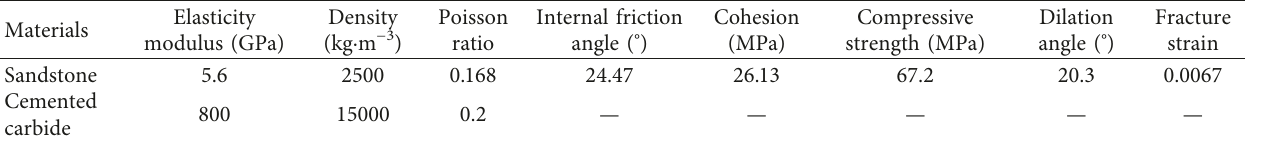
Table 1: Rock and tool material parameters.